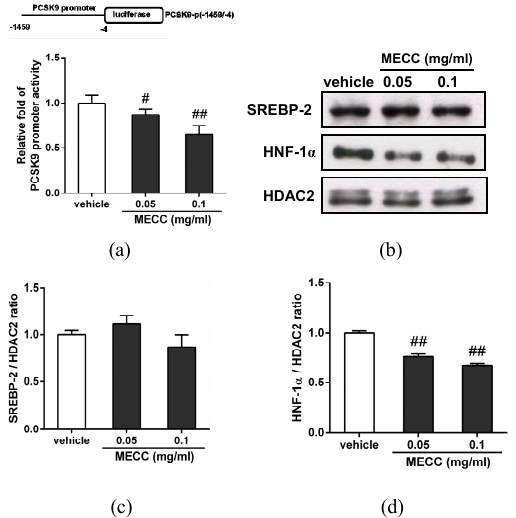
Figure 6. Effects of MECC on the PCSK9 promoter activity and transcriptional activators in HepG2 cells. ( a ) HepG2 cells were transfected with PCSK9 promoter-luciferase reporter plasmid (PCSK9-p(-1459/-4)) and Renilla control plasmid for 24 h, and treated with vehicle or MECC (0.05 and 0.1 mg/mL) for an additional 24 h. The luciferase activity was measured and normalized to the respective Renilla luciferase activity. The data are presented as the means ± SD from three independent experiments. ( b ) The nuclear SREBP-2, HNF-1 α and HDAC2 proteins were determined by Western blot analysis. The experiments were at least replicated three times, and a representative blot was shown. The normalized intensities of SREBP-2 ( c ) and HNF-1 α ( d ) versus HDAC2 are presented as the means ± SD of three independent experiments. # p < 0.05 and ## p < 0.01 represent significant differences compared to the vehicle-treated group.